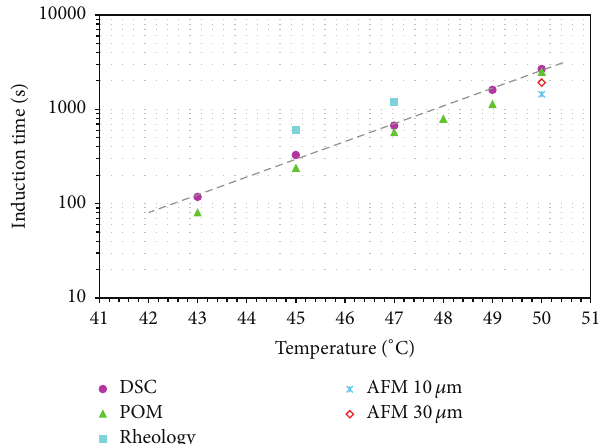
Figure 13: Induction time recorder by the different techniques. The dashed line represents a guide for